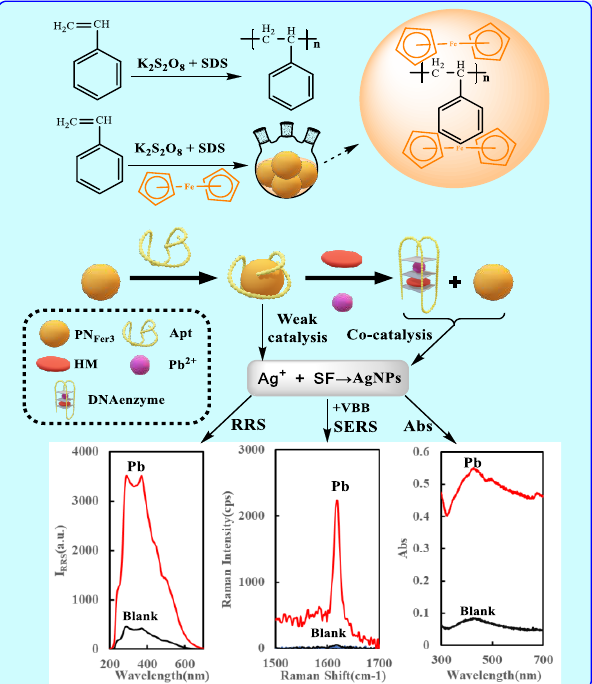
Figure 1. Preparation of ferrocene-doped polystyrene nanospheres and trimode detection of trace Pb 2+ based on ferrocene-doped polystyrene and DNA enzyme cocatalysis of AgNO 3 -sodium formate nanosilver indicator reaction.